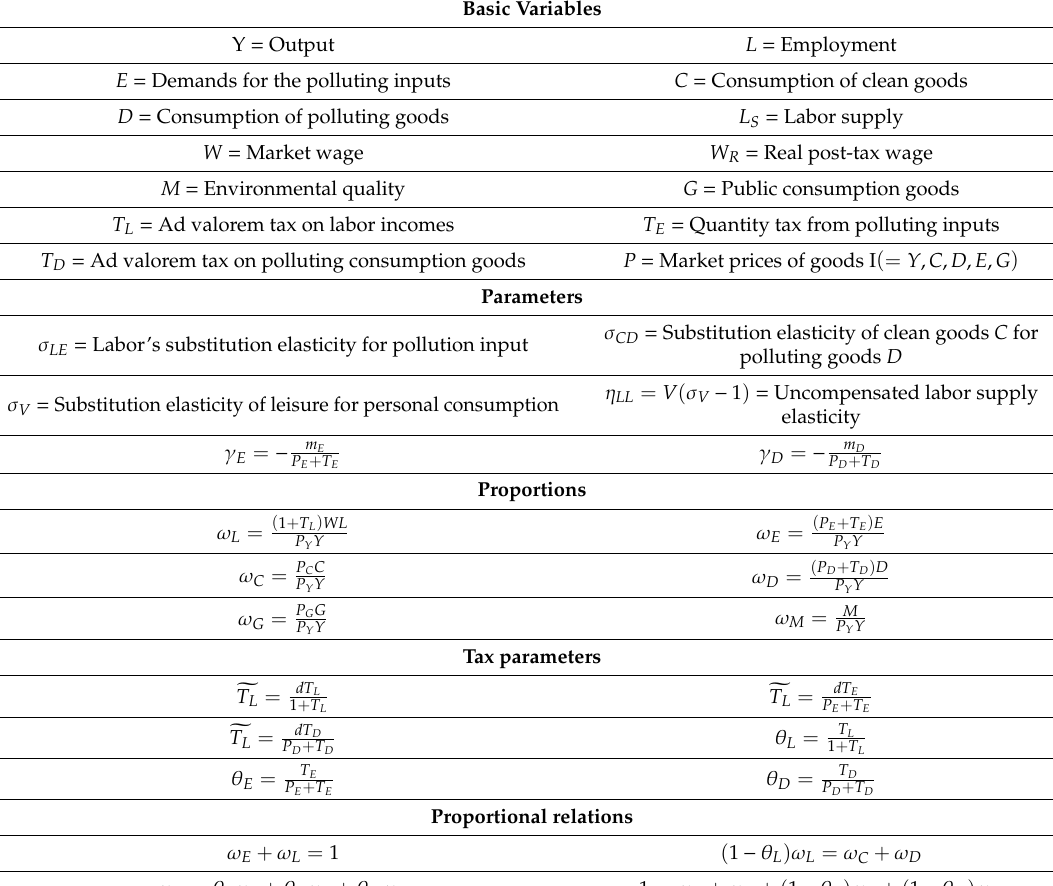
Table 1. Variables, parameters, proportions and their